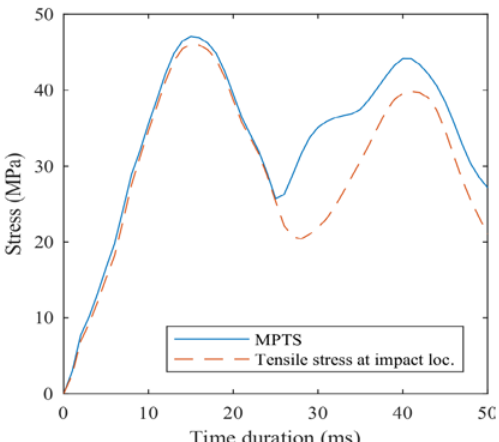
Fig. 6 Results of numerical simulations. Maximum principal tensile stress and tensile stress at the impact location (on opposite face of panel) in the case of the panel without an array of ventilation